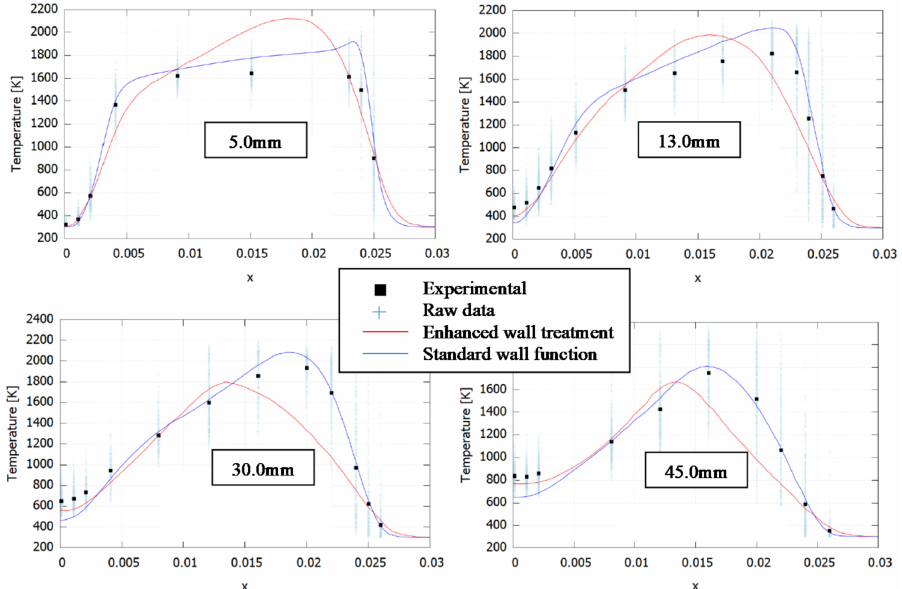
Figure 7. Temperature profiles at increasing axial distances. SAGE/GRI-Mech 3.0. Complete experimental data available at reference [15].